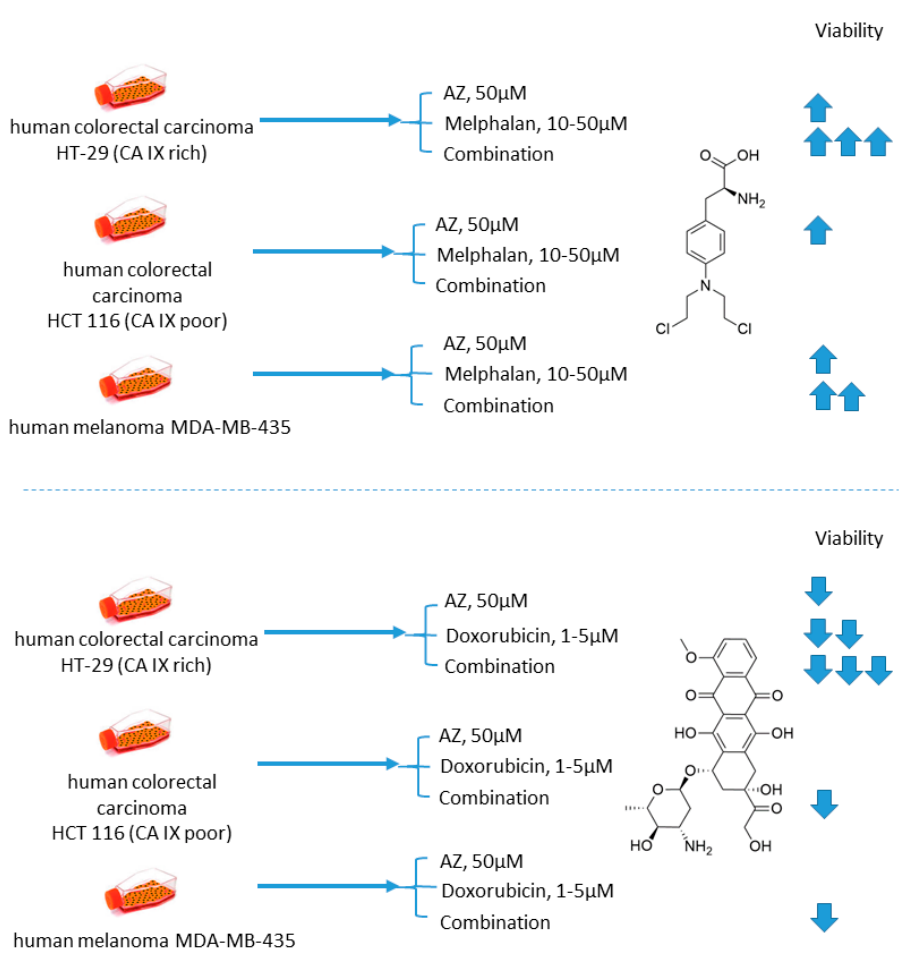
Figure 1. Graphical outline of the study on AZ+melphalan/DOX combination reported by Geiling et al.